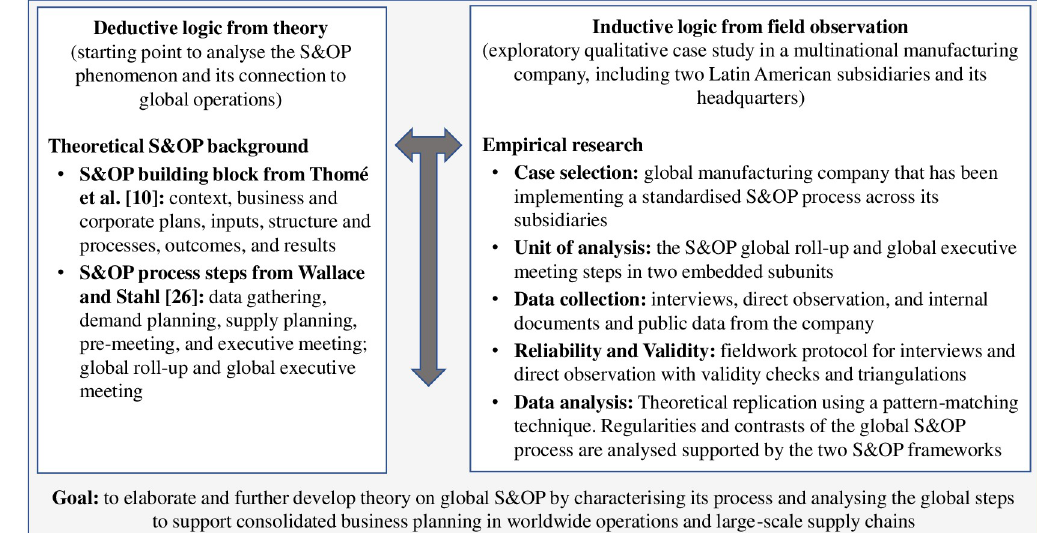
Fig 3. Research roadmap applying an abductive